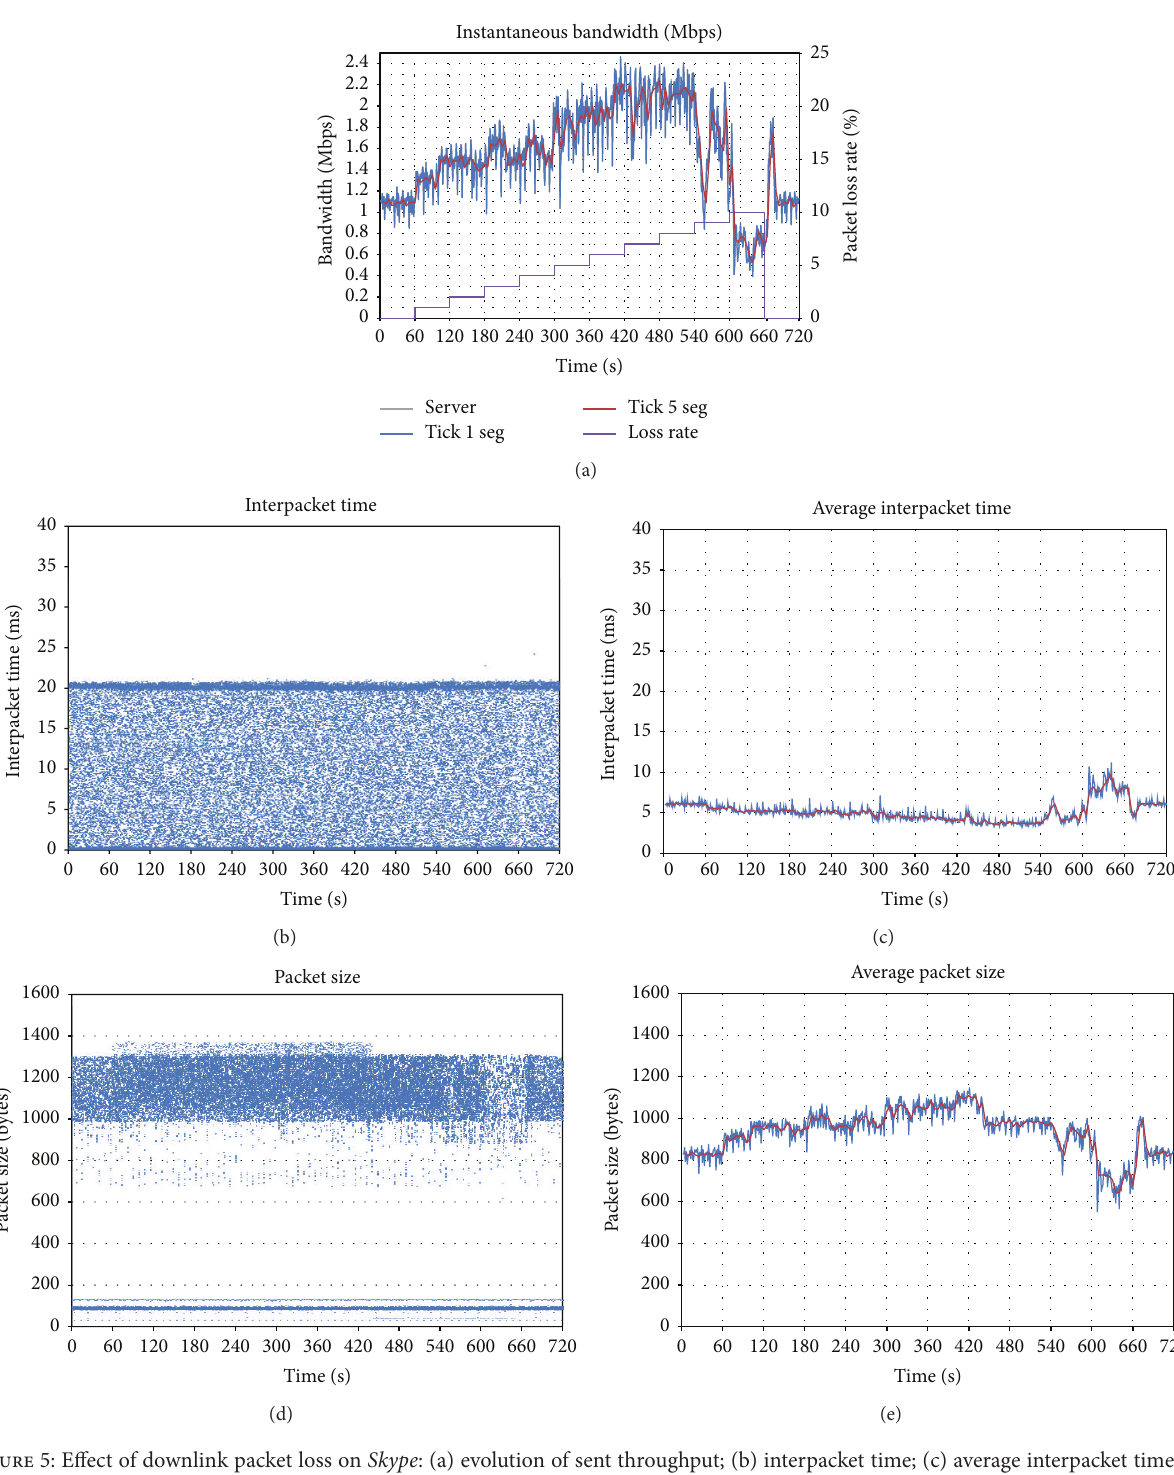
Figure 5: Effect of downlink packet loss on Skype : (a) evolution of sent throughput; (b) interpacket time; (c) average interpacket time; (d) packet size; (e) average packet